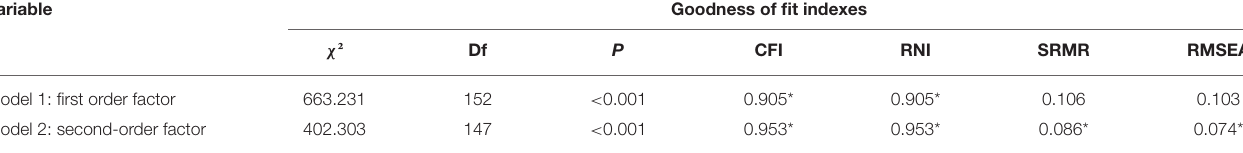
TABLE 4 | Indices of model fit